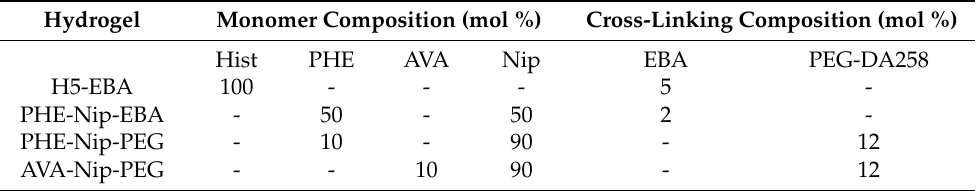
Table 1. Composition of monomers in the α -amino acid acid-based hydrogels. Hydrogel Monomer Composition (mol %) Cross-Linking Composition (mol %) Hist PHE AVA Nip EBA PEG-DA258 H5-EBA 100 - - - 5 - PHE-Nip-EBA - 50 - 50 2 - PHE-Nip-PEG - 10 - 90 - 12 AVA-Nip-PEG - - 10 90 - 12